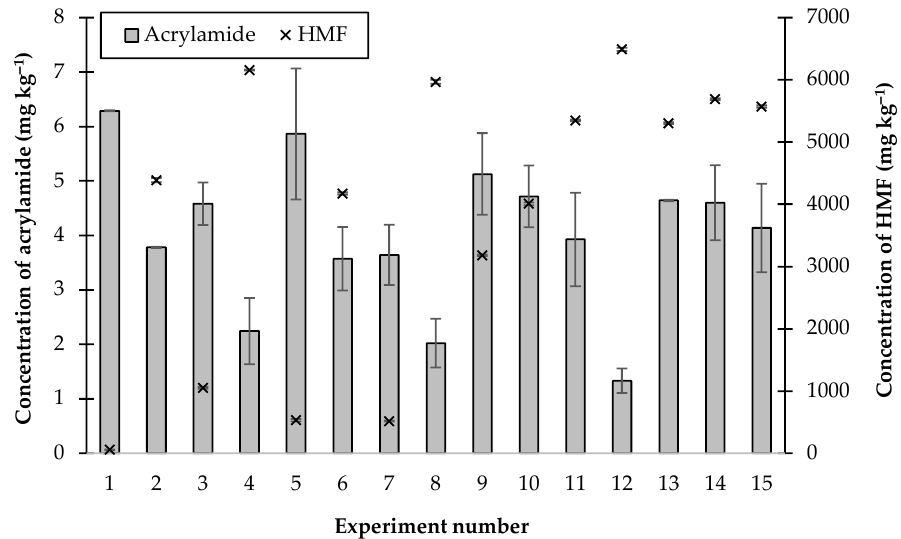
Figure 4. The concentrations of acrylamide and HMF produced by heating thick juice containing combinations of additives at 120 °C for 30 min.